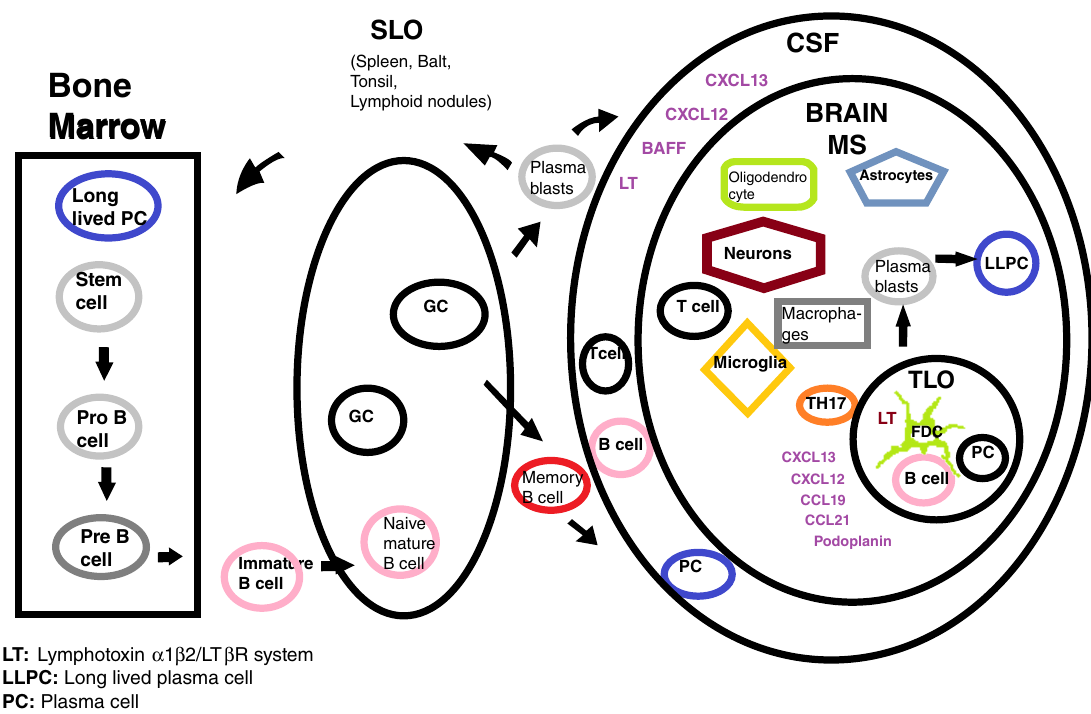
Figure 1. B cells lineage from bone marrow to CNS. B-cells originating in the bone marrow exit toward the blood stream as immature B-cells; they enter the SLO and specialize in the germinal centers producing memory B cells and plasmablasts, which in pathologic conditions, are able to gain access to the CNS. The TLO is formed in the meninges during chronic inflammation in the deep brain cortical sulci and share organogenesis with the SLO 24 . Podoplanin and the Th17 signature cytokine IL-17 have been associated with ectopic lymphoneogenesis in human diseases whereas BAFF is a key factor for mutation and survival of B cells which is produced by astrocytes in the CNS 3,25 . BAFF: B-cell activating factor of the tumor necrosis factor family; Balt: bronchial associated lymphoid tissue; CCL19: chemokine (c-c motif) ligand 19; CSF: cerebrospinal fluid; CXCL13: chemokine (C-X-C motif) ligand 13; FDC: follicular dendritic cells; GC: germinal center; LT: lymphotoxin α 1 β 2/LT β R system; LLPC: long lived plasma cells; MS: multiple sclerosis; PC: plasma cell; SLO: secondary lymphoid organ; TLO: tertiary lymphoid